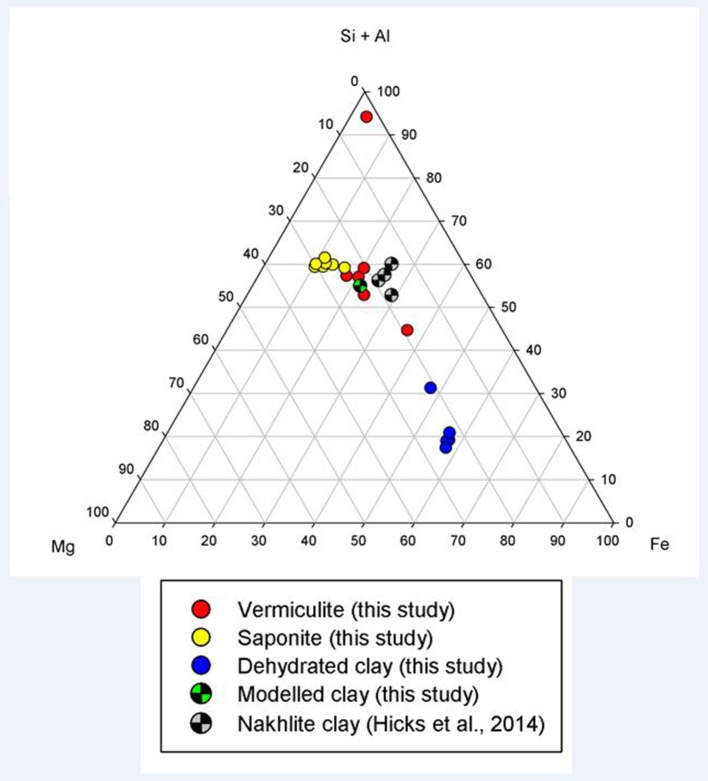
Ternary plot of (Si+Al)–Mg–Fe showing the clay mineral compositions observed in this study (filled circles), in the models of this study (checkered green circle), and in the nakhlite martian meteorites (checkered gray circle; Hicks et al., 2014).